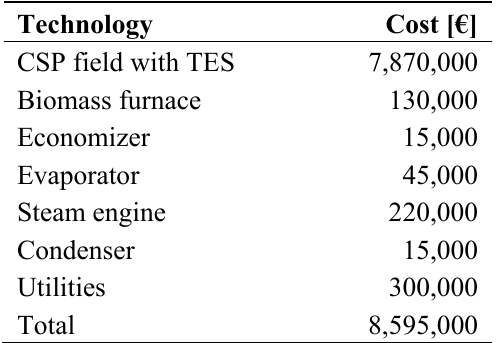
Table 7. Plant land estimated capital